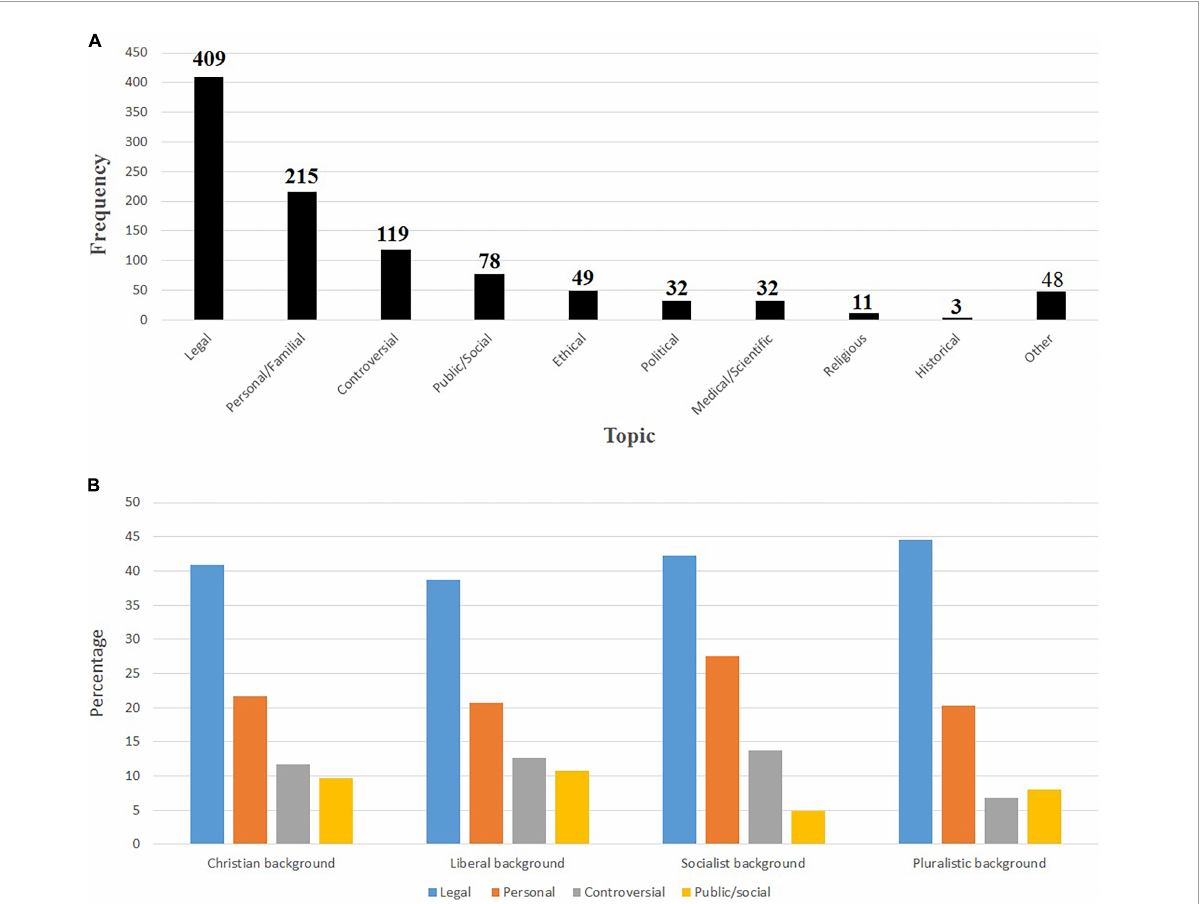
FIGURE4 (A) Topic(s) featured in the headline. (B) Most important angles to approach the euthanasia case according to historical ideological background of newspapers and